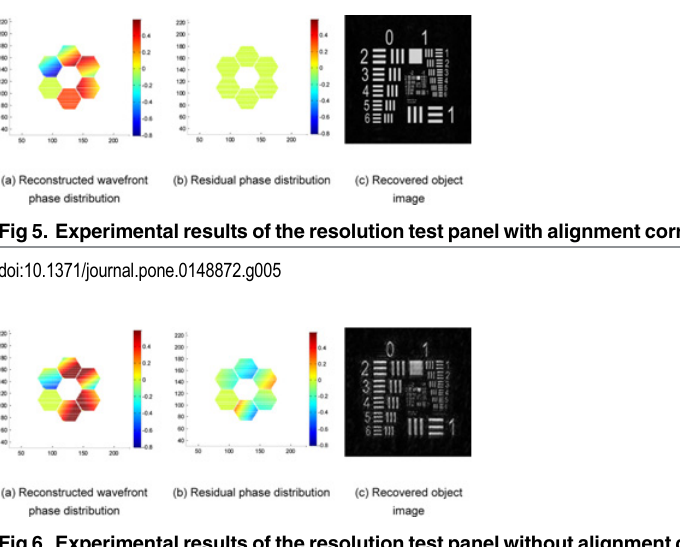
Fig 6. Experimental results of the resolution test panel without alignment correction.